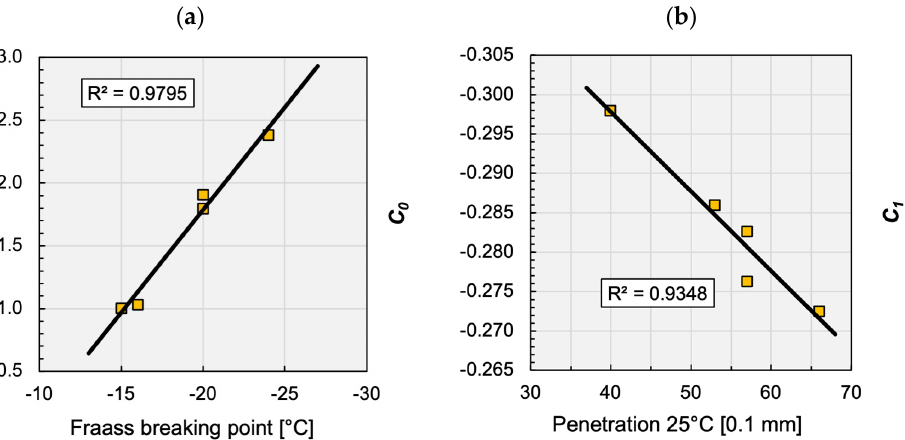
Figure 7. Assumed relationship between RAMBO model parameters: ( a ) Fraass breaking point vs. C 0 and ( b ) penetration vs. C 1.